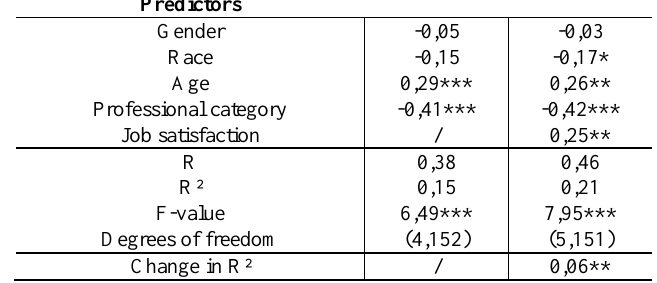
Table 4: Results of a regression analysis with affective organisational commitment as dependent variable, and background characteristics and job insecurity as